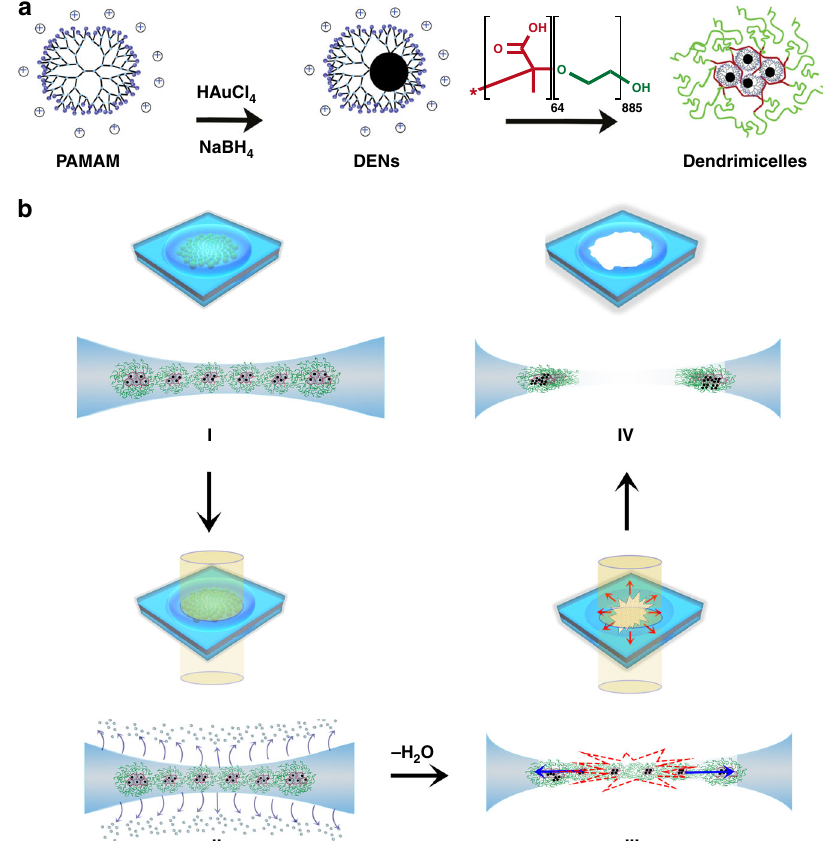
Fig. 1 Synthesis and manipulation of monolayer dendrimicelle superstructures. a Complexation and reduction of Au(III) ions inside PAMAM dendrimers provides dendrimer-encapsulated gold nanoparticles (AuDENs). Mixing of these AuDENs with a negative-neutral pMAA 64 PEO 885 block copolymer results in ~50 nm dendrimicelles. b For cryoTEM, micrometer-sized grid holes are fi lled with an aqueous thin dendrimicelle fi lm, with the biconcave shape of this layer acting as a template for the organization of dendrimicelles into (sub-) micrometer-sized monolayer superstructures (I). Exposure of the superstructure to an electron beam results in evaporation of water (II). Prolonged exposure results in the rupture of the superstructure, with the embedded AuNPs revealing local movements of dendrimicelle building blocks as well as the global migration of dendrimicelles during the nanoexplosion (III). After the nanoexplosion, a hole similar in size to the superstructure is left behind